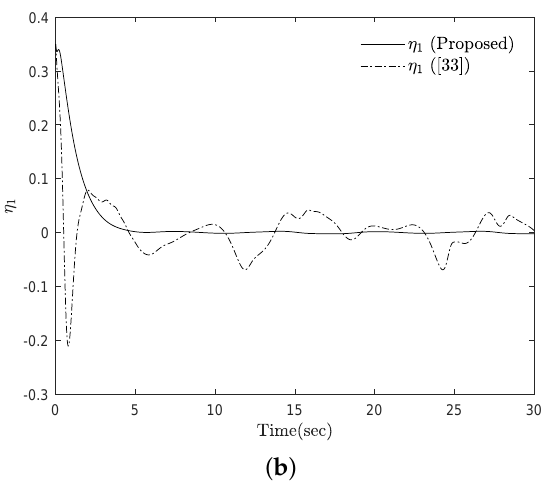
Figure 4. Tracking result and error for Example 2: ( a ) x 1 and r ; ( b ) η 1 .